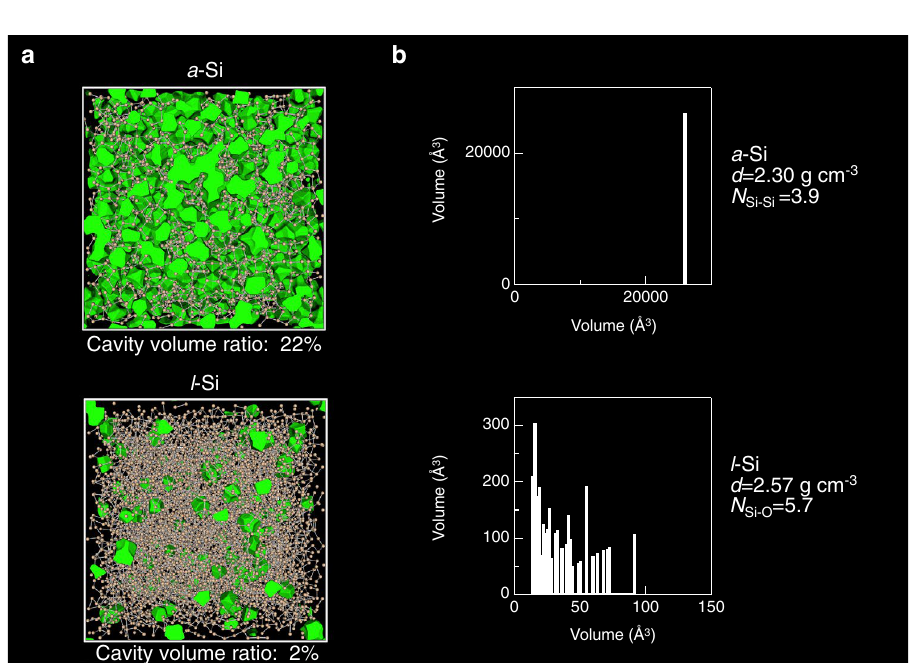
Figure 6. ( a ) Visualization of cavities and ( b ) cavity size distributions in a -Si and l -Si (1770